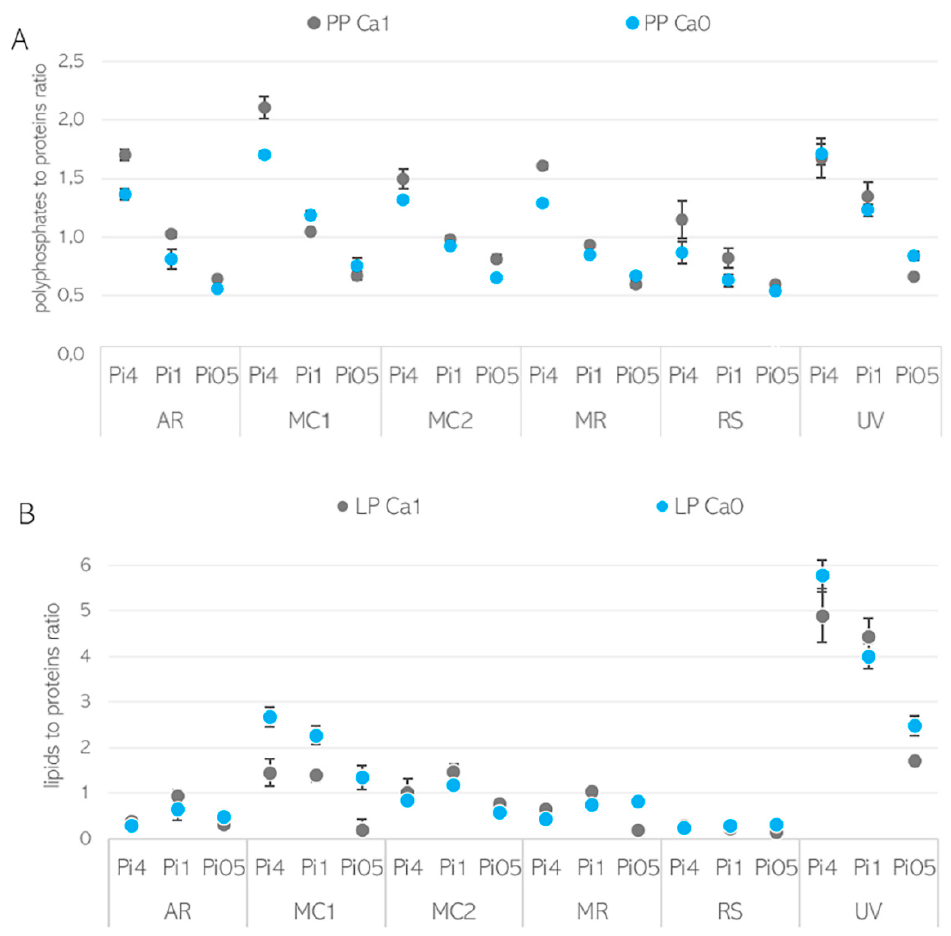
Figure 6. ( A ) Polyphosphate-to-protein (PP) and ( B ) lipid-to-protein (LP) ratios of characteristic bands in FTIR spectra of fungal biomass. Both shown for the presence (Ca1, grey) and absence (Ca0, blue) of calcium in the growth media.